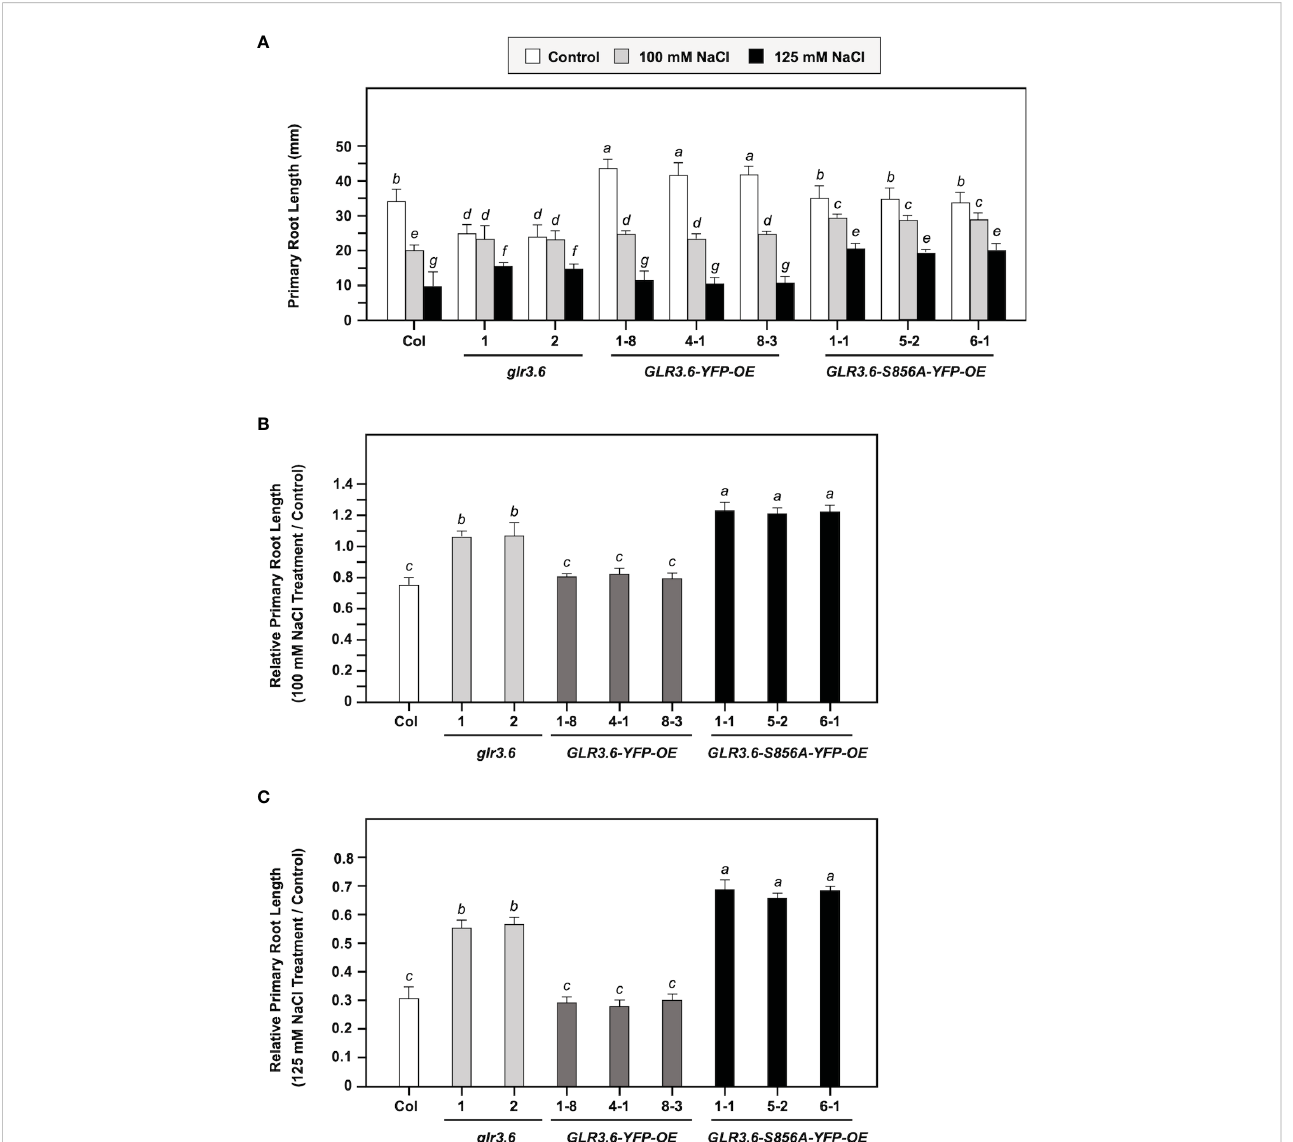
FIGURE 9 Phenotypes of glr3.6 , GLR3.6-YFP, and GLR3.6-S856A-YFP-overexpression plants under normal growth conditions and salt stress. Four-day-old seedlings with similar root lengths were transferred to 1/2 MS plates without and with 100 mM NaCl or 125 mM NaCl for 6 days, respectively. (A) The primary root length was measured. (B, C) Relative primary root length (NaCl treatment/control) was calculated. The data are presented as mean values ± SD. N = 3. Various letters indicate signi fi cant differences compared with Col plants and control ( P < 0.05, Turkey ’ s-test one-way